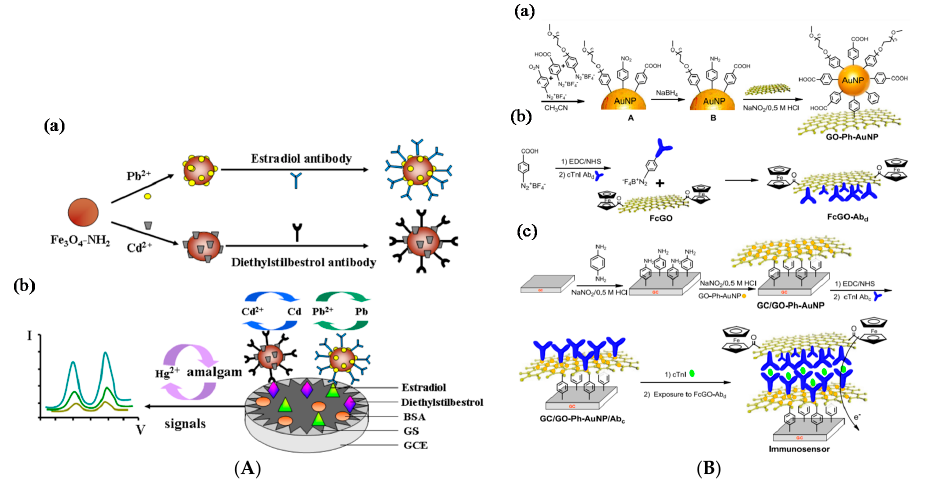
Figure 14. ( A ) ( a ) Fe 3 O 4 /M 2+ /Ab labels and ( b ) immunosensing and transduction for estradiol and diethylstilbestrol detection. Reprinted from [86], Copyright 2014, with permission from Elsevier. ( B ) ( a ) GO/AuNP; ( b ) Fc-modified and Ab-modified GO; ( c ) Assembly of these functionalized GO sheets for cTnI detection. Drawings are not at scale. Reprinted from [87], Copyright 2016, with permission from Elsevier.